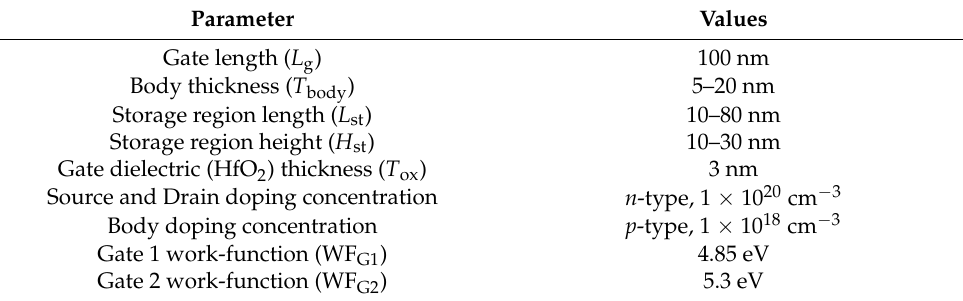
Table 1. Device parameters of proposed 1T-DRAM used for simulation.